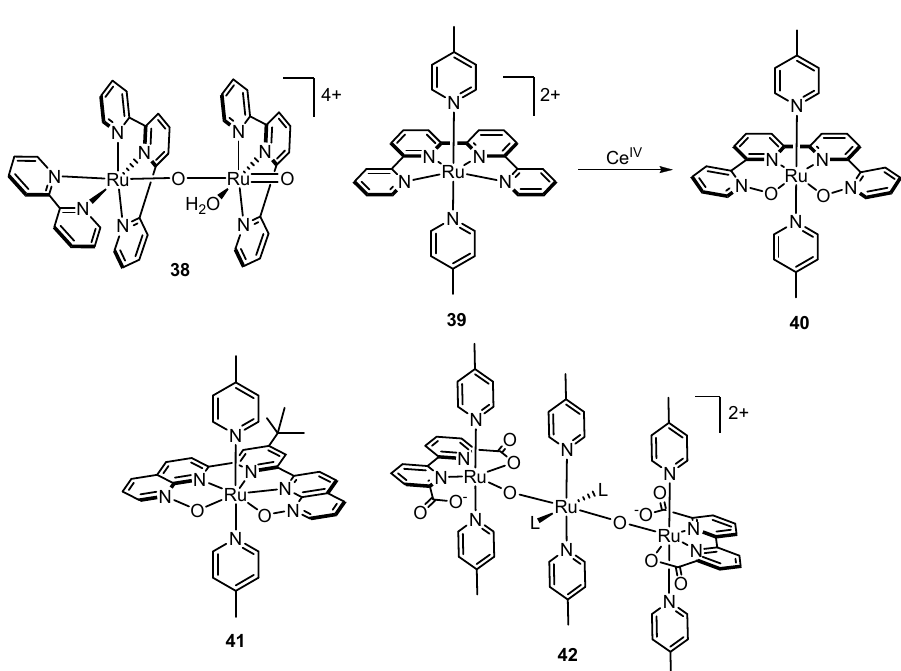
Figure 20. Various species derived from catalyst modification under oxidative conditions.